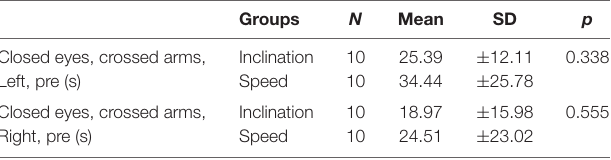
TABLE 2 | Normality test of CECAOLS in both groups before training.